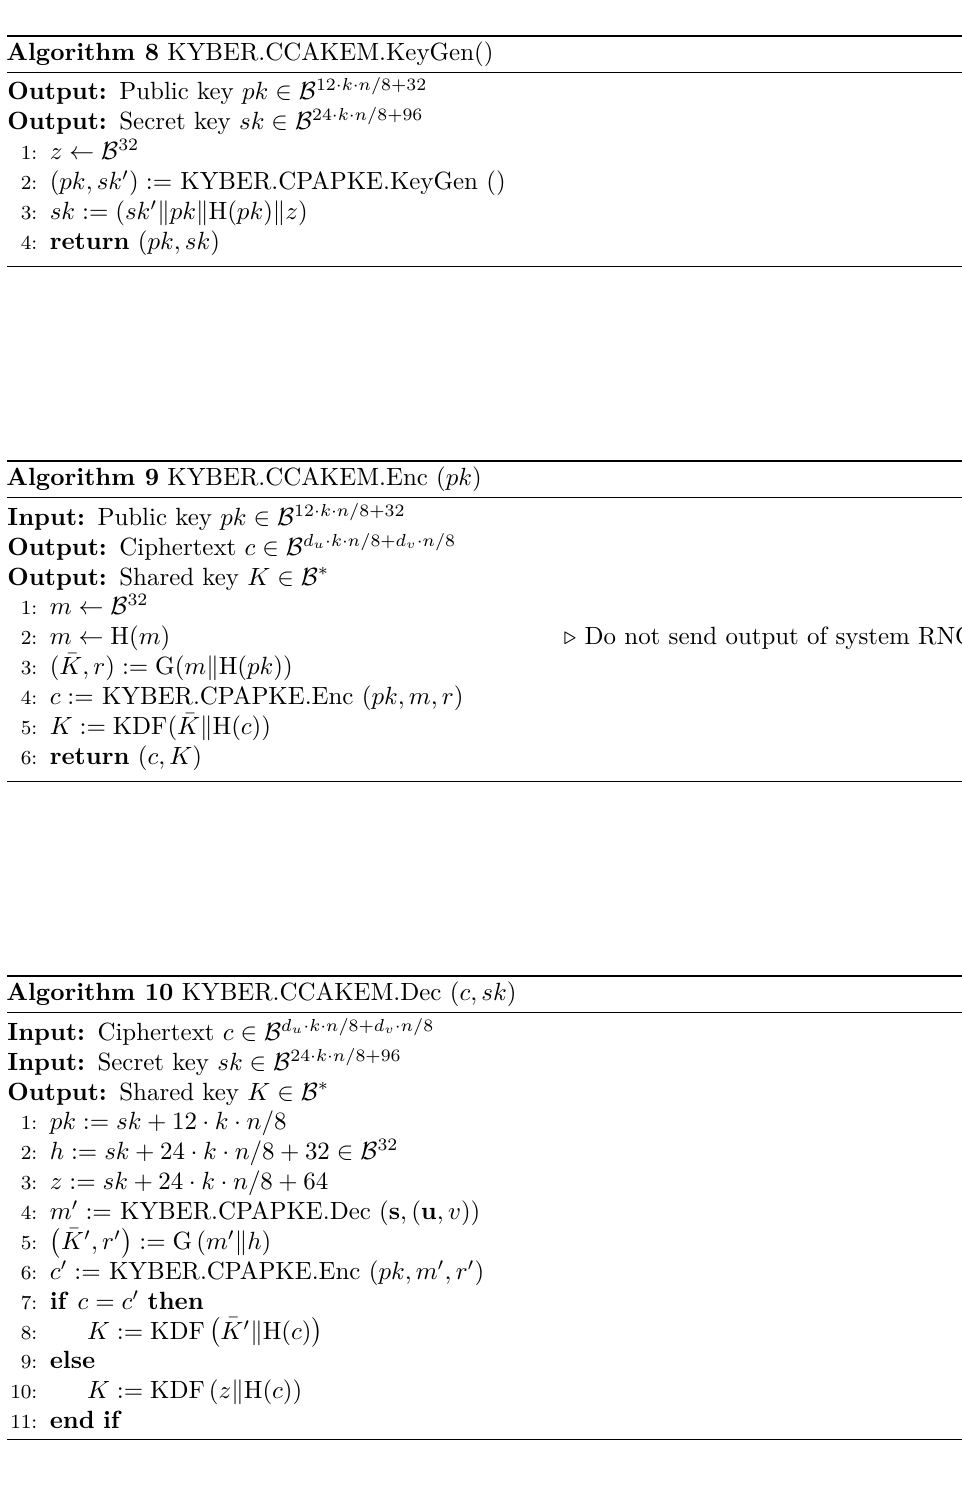
Algorithm 8 KYBER.CCAKEM.KeyGen()